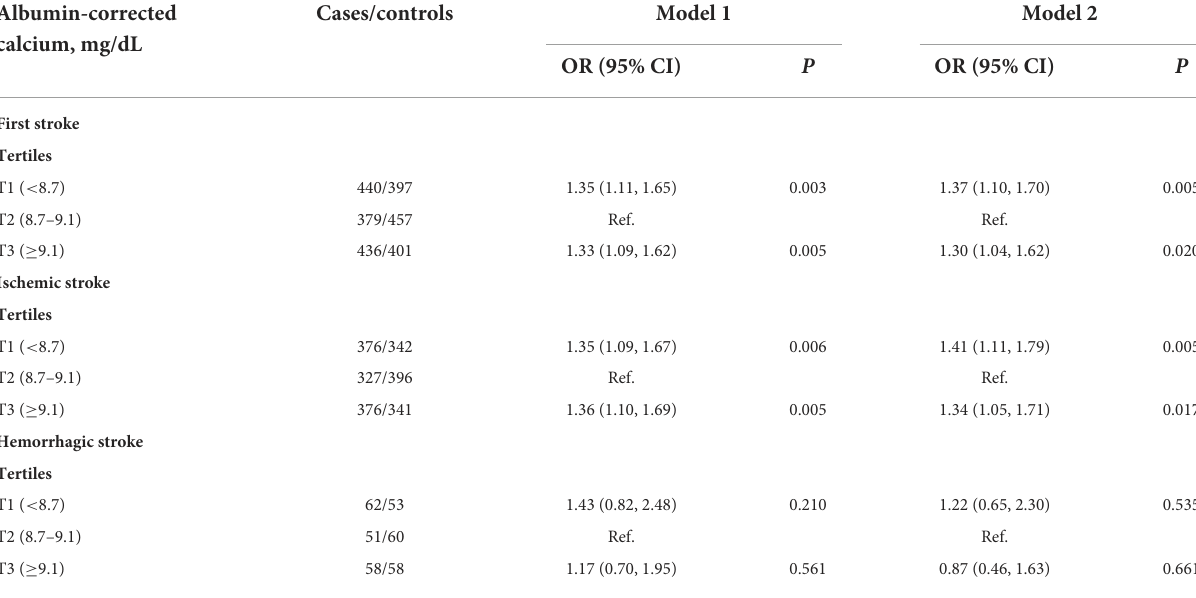
TABLE 2 Risk of first stroke (total and subtypes) associated with serum albumin-corrected calcium levels * . Albumin-corrected Cases/controls calcium, mg/dL